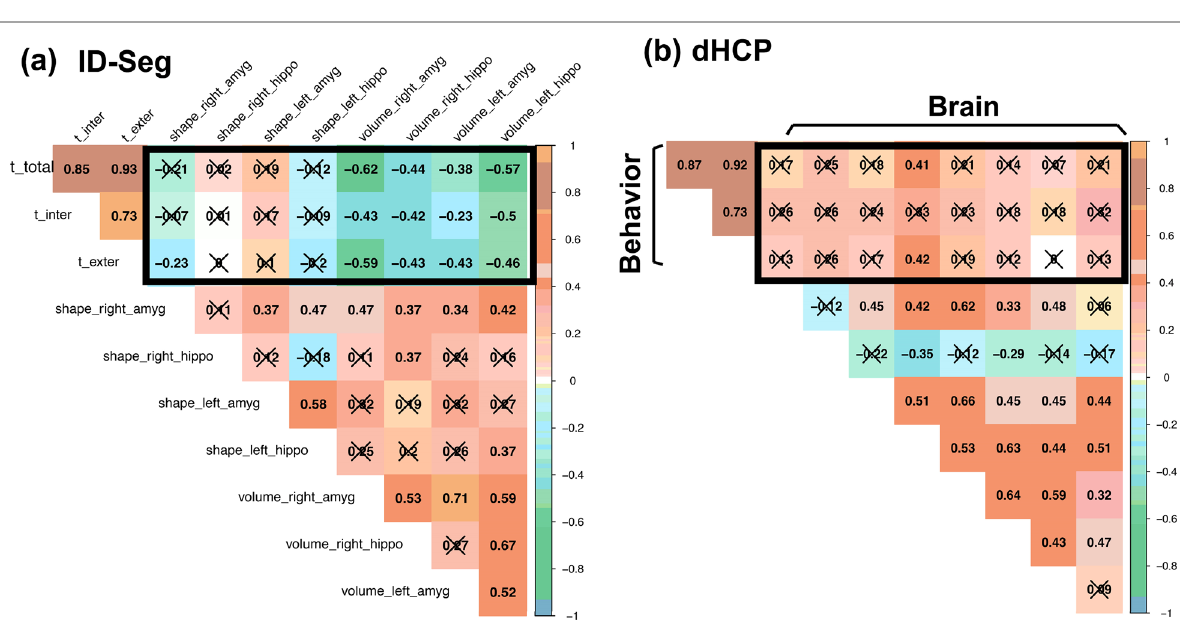
Fig. 3 Brain–behavior relationships (in black rectangles) for a ID-Seg, b dHCP. X indicates that the p value of spearman correlation is not significant at the threshold of p 0.05. t_total CBCL total problems T score, t_inter CBCL internalizing problems T score, t_exter CBCL externalizing problems T = score, amyg amygdala, hippo